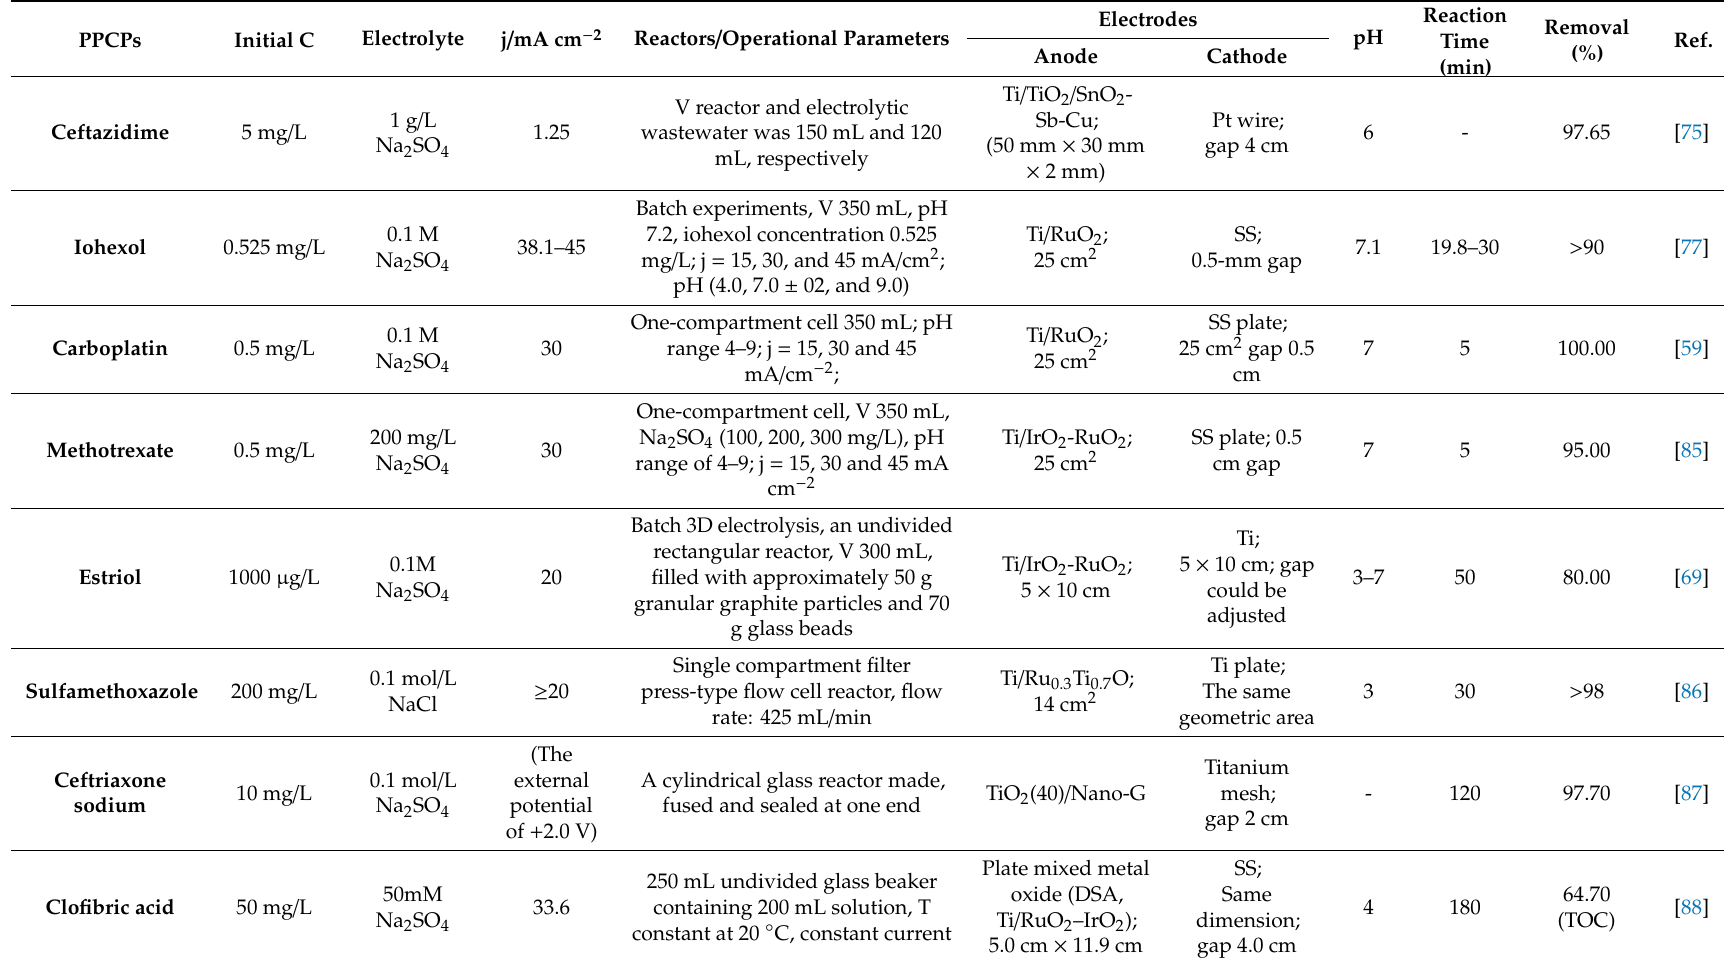
Table 5. Selected results reported for PPCPs removal by EOP with dimensionally stable anode (DSA)